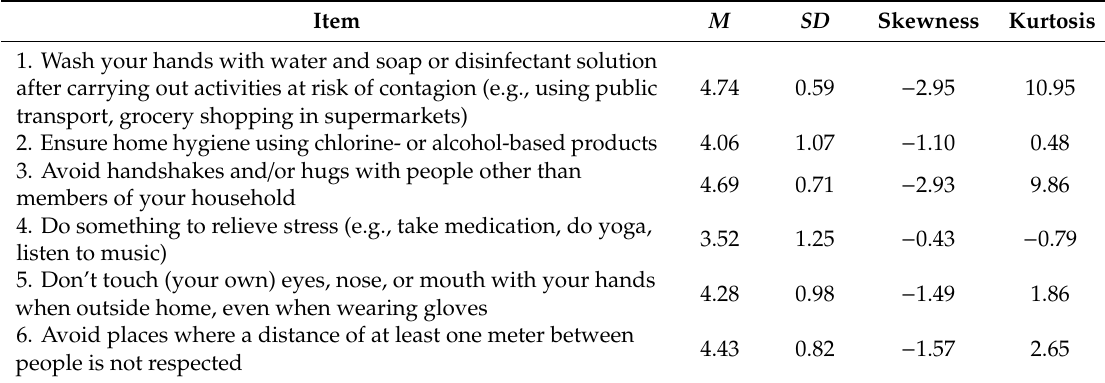
Table 2. Descriptive statistics for individual items of the SCOVID scale ( N =